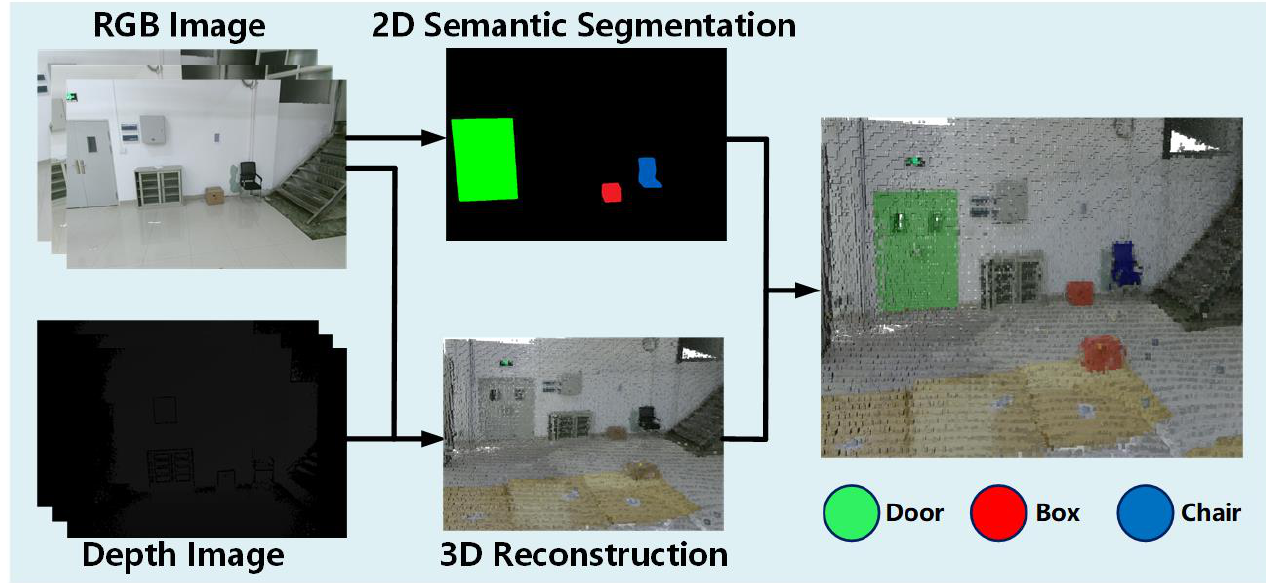
Figure 1. Dense semantic mapping: The figure shows an example of our system. The RGB images and depth images are used to reconstruct 3D environments, and the door, box, and chair in the RGB images are colored with respect to semantic information in green, red, and blue, respectively, by semantic segmentation. Finally, the semantic information is combined with the 3D reconstructed map and presented in the form of an